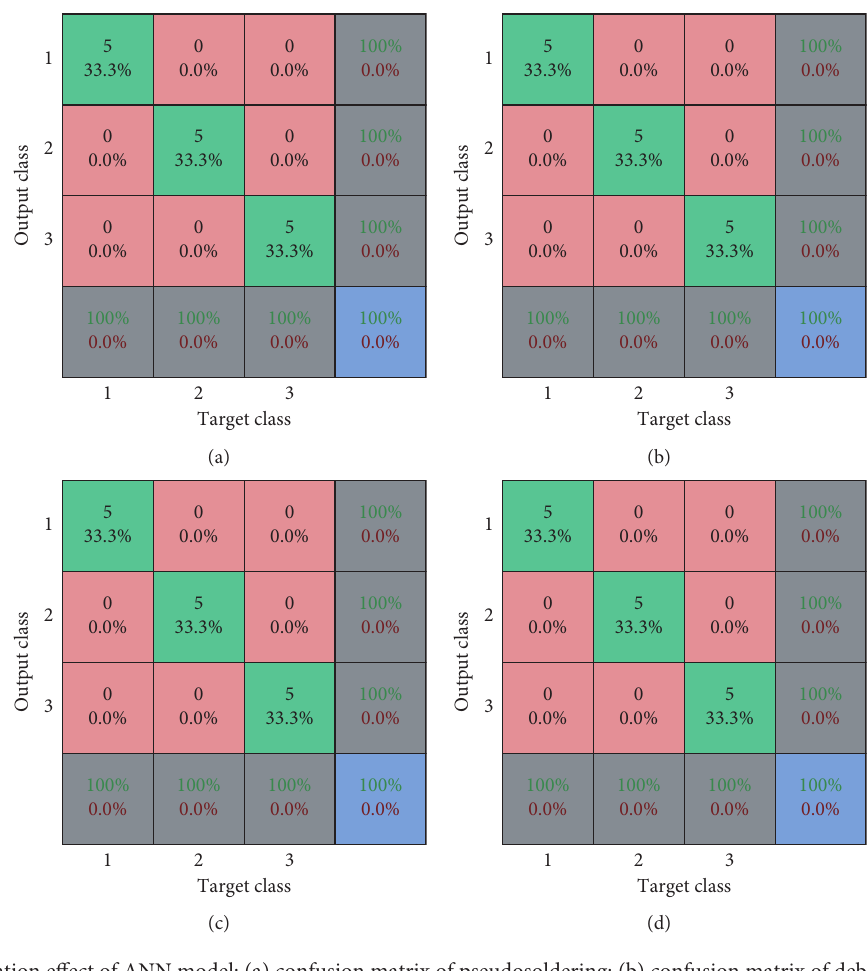
Figure 17: Classification effect of ANN model: (a) confusion matrix of pseudosoldering; (b) confusion matrix of debonding; (c) confusion matrix of wear; (d) confusion matrix of